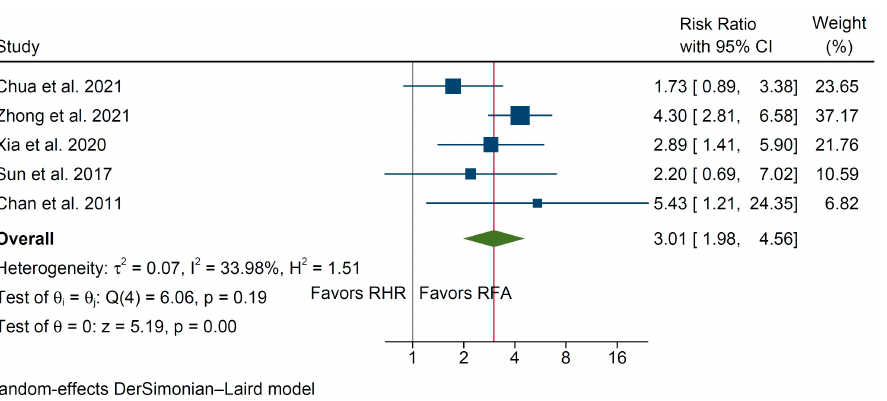
Figure 6. Forest plot of major morbidity between the RHR and RFA groups [22 – 24,27,29,30,32,34,36,38]. Data on post-procedural mortality were available in 12 studies with 2447 total pa- tients (1024 in the RHR vs. 1423 in the RFA group, Table 3). Overall, six deaths were reg- istered in the RHR group (0.5% mortality rate) and three in the RFA group (0.2% mortality rate), without any existing statistically significant difference between the two groups (RR 1.6, 95% C.I. 0.64 to 4.02, p = 0.32, Figure 7) and no interstudy heterogeneity (I 2 = 0%).